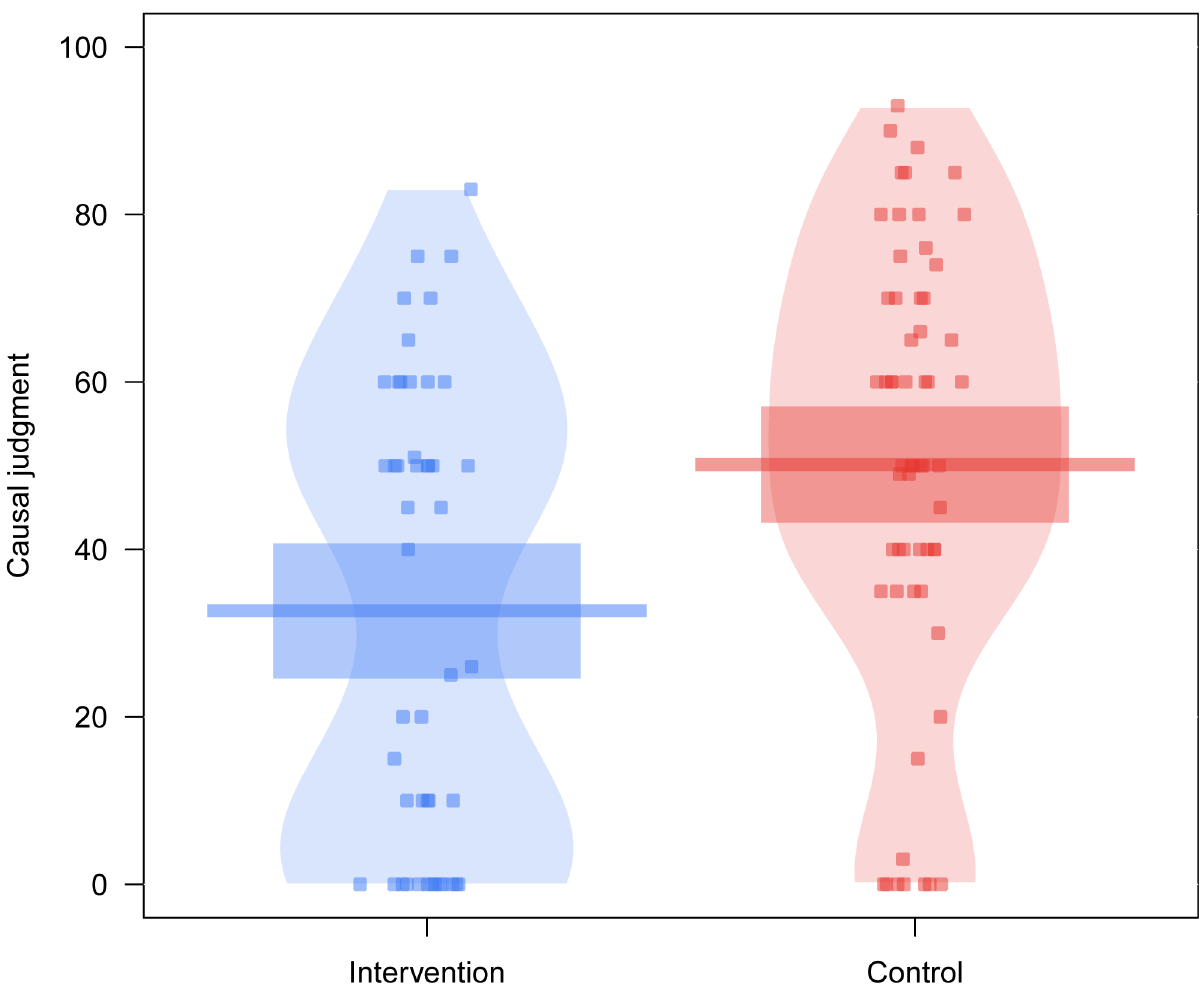
Fig 1. Intensity of the causal illusion. For each condition, the points represent the raw data, the horizontal lines represent the mean causal judgments, and the rectangles the 95% confidence